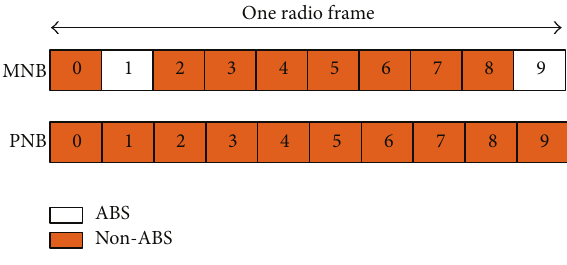
Figure 2: Example of ABS for eICIC